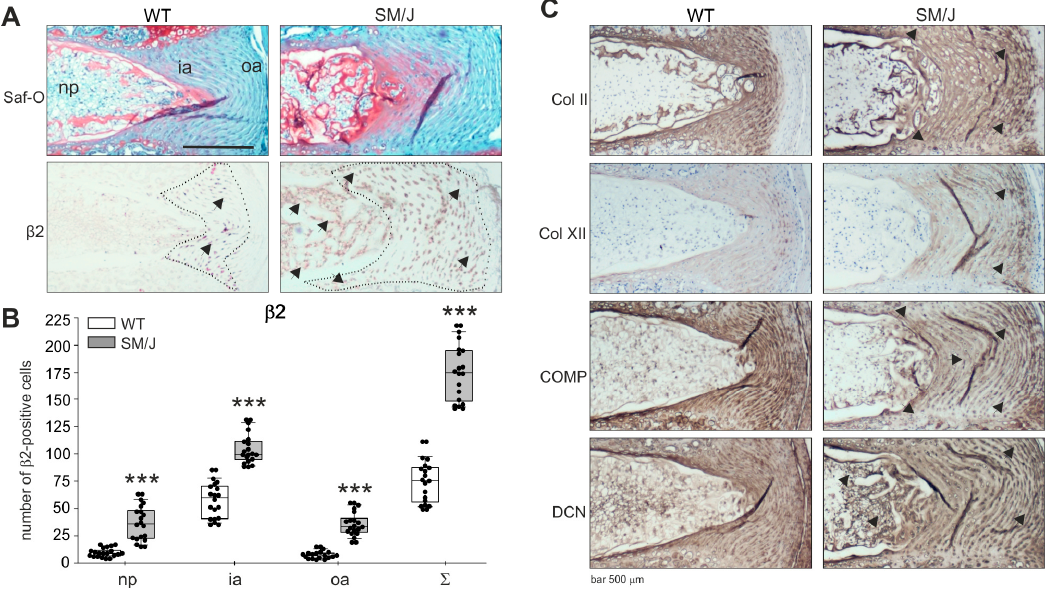
Figure 5. Localization of ARs and distribution of ECM proteins in murine IVD tissue. ( A ) Immunohistochemical analysis of β 2-AR (black arrows and IVD regions indicated by the dotted line) and Col II, Col XII, COMP as well as DCN in IVD sections of WT and SM/J mice (bars 500 μ m, n = 3). ( B ) The number of β 2-positive cells in WT and SM/J IVD tissue ( n = 3). Each black circle represents the number of β 2-positive cells per section of an individual mouse (6 sections per mouse per genotype analyzed). Data are presented as box plots, which are described in the legend to Figure 2. Significant p -values against WT are presented as “***” p ≤ 0,0001. ( C ) Immunohistochemical analysis of type II